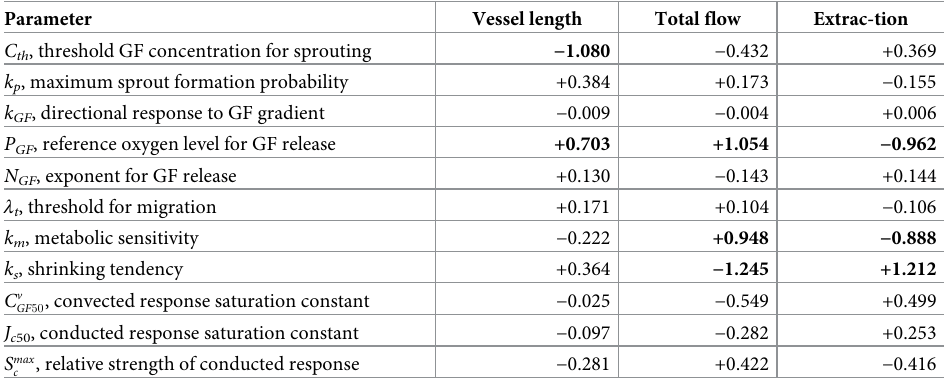
J c 50 , conducted response saturation constant − 0.097 − 0.282 +0.253 , relative strength of conducted response − 0.281 +0.422 − S max c